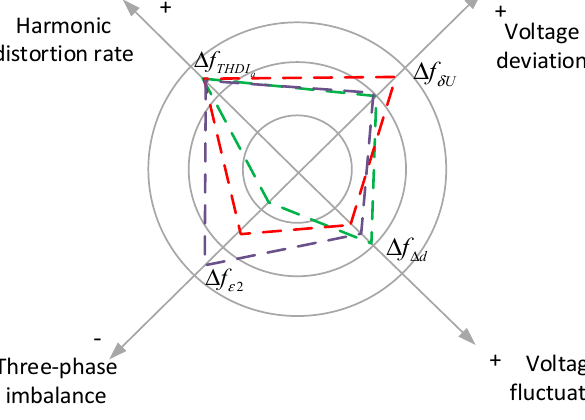
Figure 2. Schematic of the sensitivity radar. 349